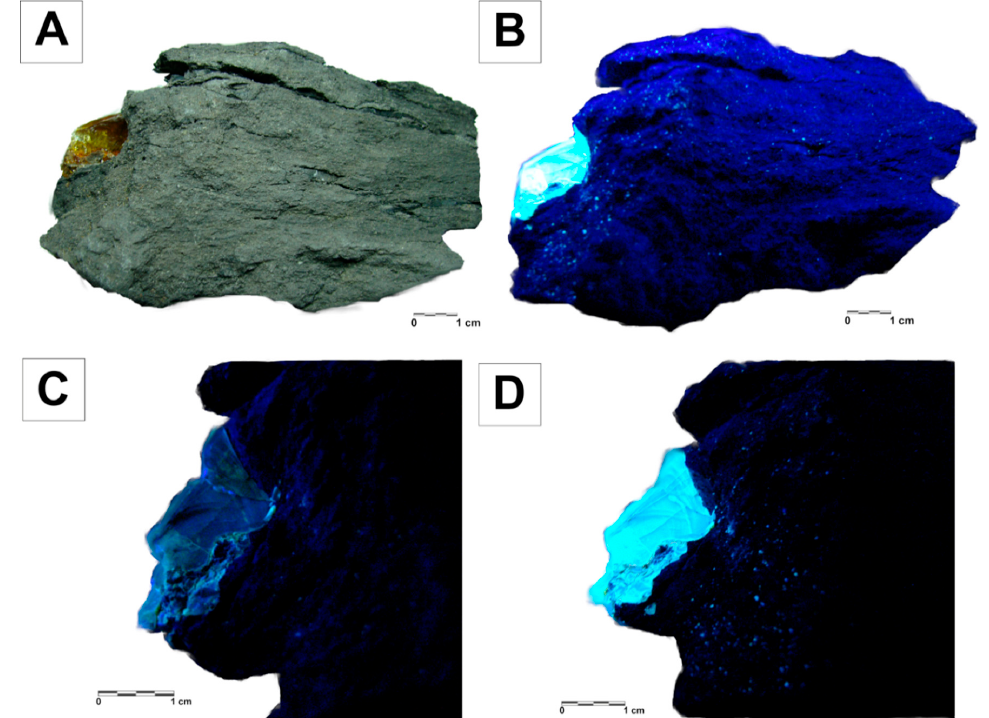
Figure 3. ( A ) Sample of coaly shale with large and tiny fossil resin pieces and a fine stratified texture; ( B ) The rock under UVL light (365 nm); Various colors and intensities of fossil resin fluorescence under UVS light = 254 nm ( C ) and under UVL light = 365 nm ( D ).